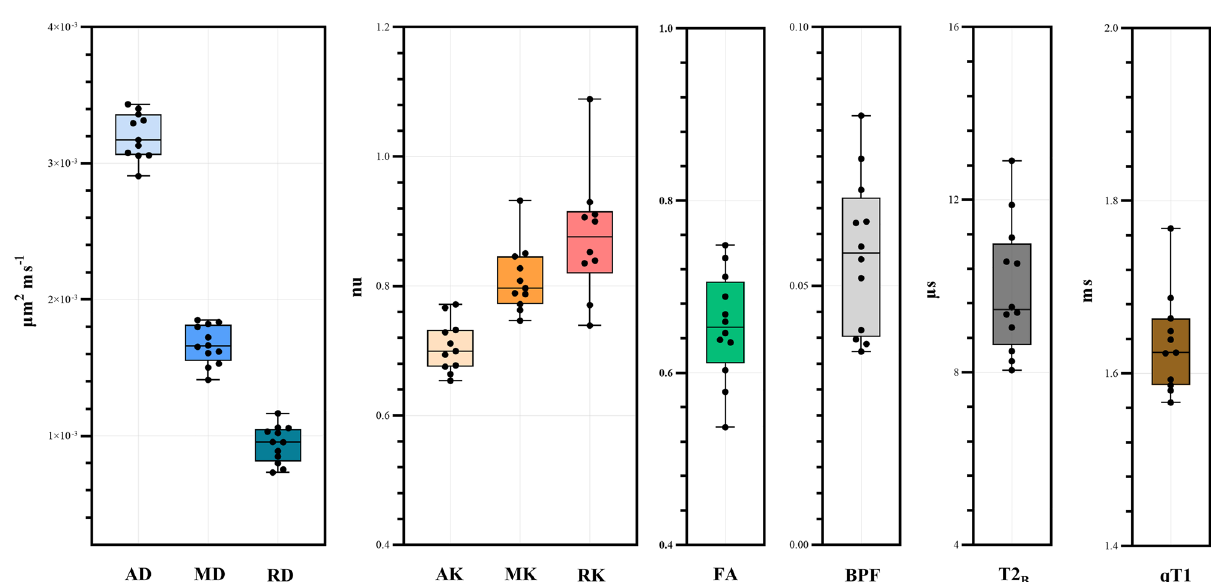
Figure 4. Boxplots with mean (± SD) values of the standard diffusion tensor (DTI) metrics axial/radial/mean diffusivity (AD/RD/MD) and fractional anisotropy (FA), diffusion kurtosis imaging (DKI) metrics axial/radial/ mean kurtosis (AK/RK/MK), quantitative magnetisation transfer (qMT) metrics bound pool fraction and bound pool transverse relaxation time (BPF/T2 B ) and quantitative longitudinal relaxation time (qT1), in the sciatic nerve of 12 healthy